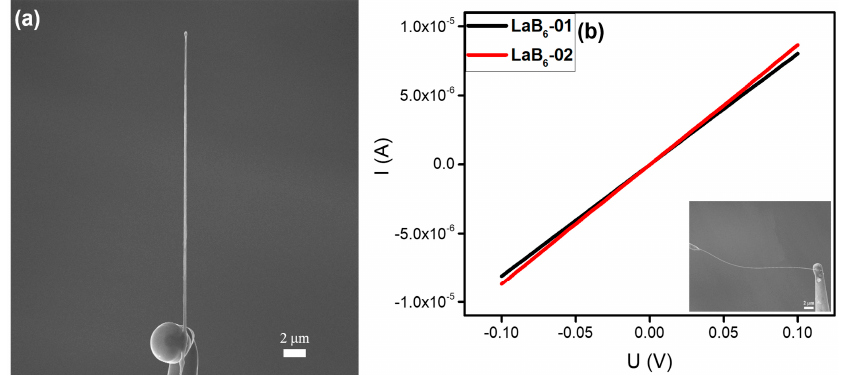
Figure 2. ( a ) SEM image of an individual LaB 6 nanowire welded onto a tungsten needle. ( b ) Typical current versus voltage (I-V curves) of two individual LaB 6 nanowires. Typical SEM image of the in-situ electrical measurement is given as an